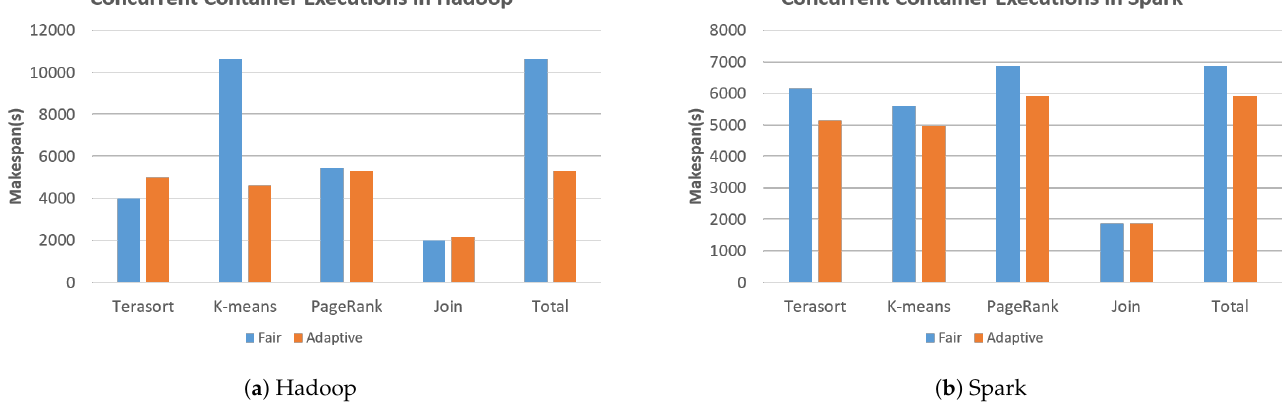
Figure 3. Experimental results of concurrent container executions that can show the aggregated throughput improvements of our proposed